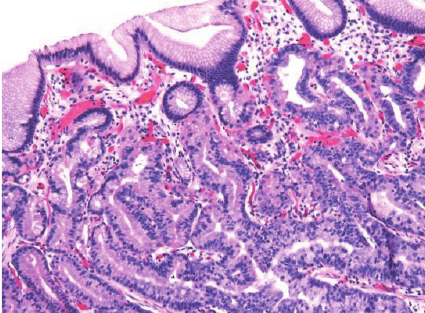
Figure 3: Continuity between the neoplastic glands and the fundic glands, indicating that the tumor arouse from the fundic gland (H&E × 100).